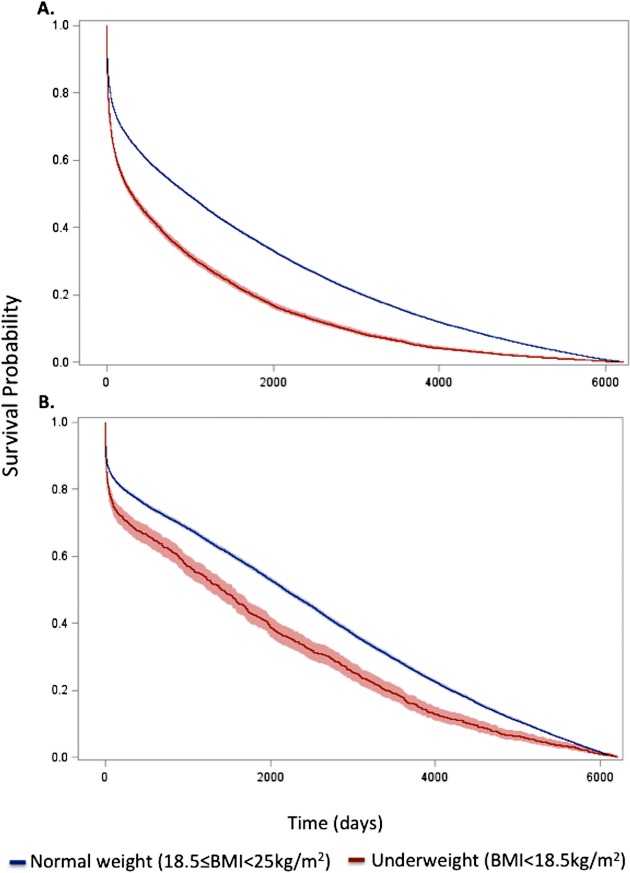
Kaplan–Meier survival curves for underweight and normal weight among all
patients and the subset of patients without significant comorbidity or
frailty.Curves for (A) all patients and (B) the subset of patients without
significant comorbidity or frailty. The lines represent the Kaplan–Meier
survivor functions, and the shaded areas are the 95% confidence limits.
p-Value for log-rank test < 0.001 for both
comparisons.